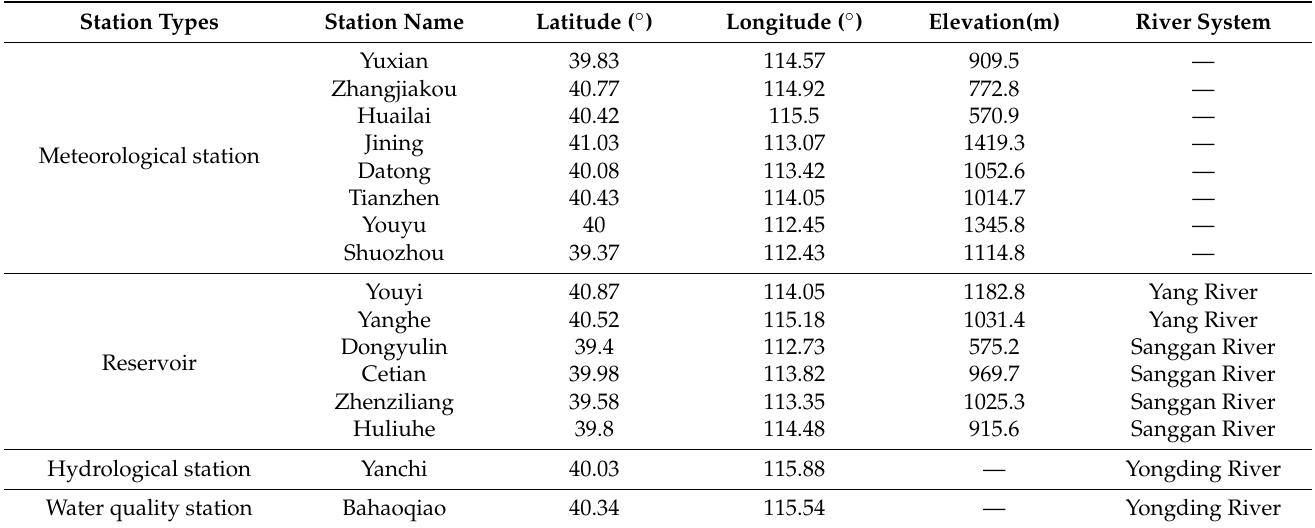
Figure 1. Location of the Guanting Reservoir watershed and study area. Table 1. Location Information of Meteorological Stations, Reservoirs, Hydrological Stations, and Water Quality